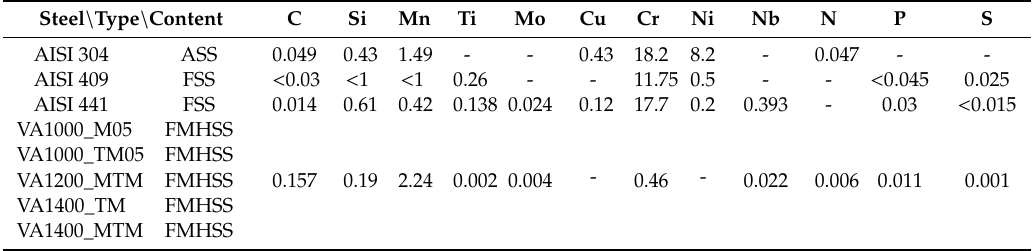
Table 1. Chemical composition of the steels selected for training and validation of the artificial neural network (ANN) models